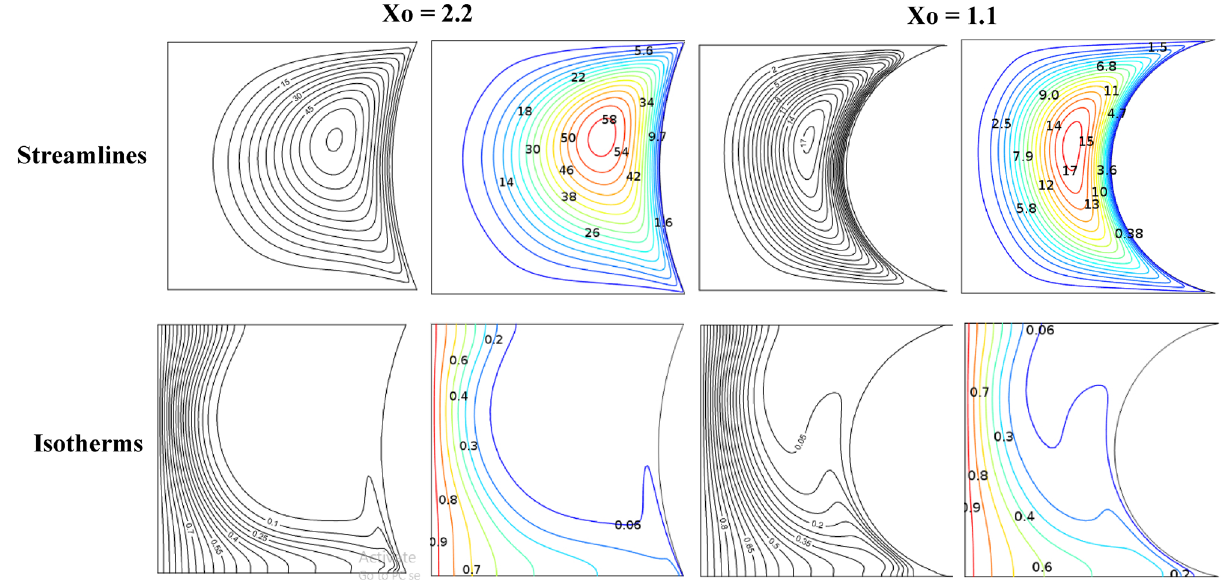
Figure 4. Streamlines (upper row) and isotherms (lower row) for Ra = 10 4 and ω = 500.